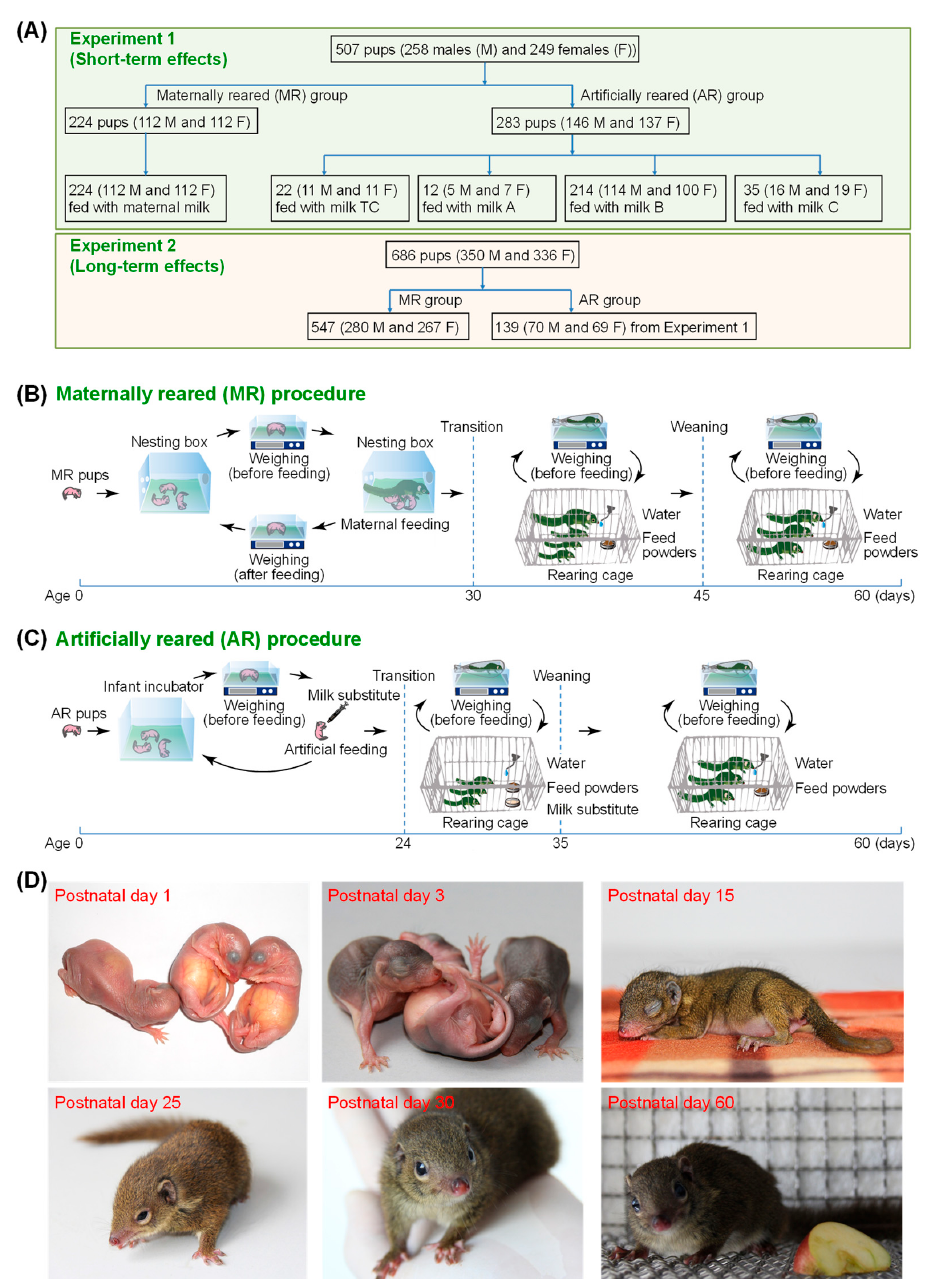
Figure 1. Experimental design and milk feeding procedures in this study. ( A ) Two experiments were conducted to evaluate the short-term effects (Experiment 1) and the long-term effects (Experiment 2) of milk substitutes on the survival and reproductive performance of the Chinese tree shrews. ( B , C ) Procedures of milk feeding for the tree shrew pups fed with maternal milk ( B ) and artificial milks ( C ) in Experiment 1. A total of 224 pups were included in the maternally reared (MR) group, and 283 pups were included in the artificially reared (AR) groups (milk TC, n = 22; milk A, n = 12; milk B, n = 214; and milk C, n = 35). Objects in ( B , C ) are not drawn to scale. ( D ) Photographs of the pups fed with milk B at different ages. On postnatal day 1, pups had smooth, pink skin with eyes closed, and their stomachs are full of milk. On postnatal day 3, pups had black skin due to pigmentation. On postnatal day 15, pups developed a white underbelly and a coat of brownish thick fur. On postnatal day 25, pups were able to move and have their eyes open. On postnatal day 30, pups became active and curious about their surroundings. On postnatal day 60, pups had a similar size and appearance to